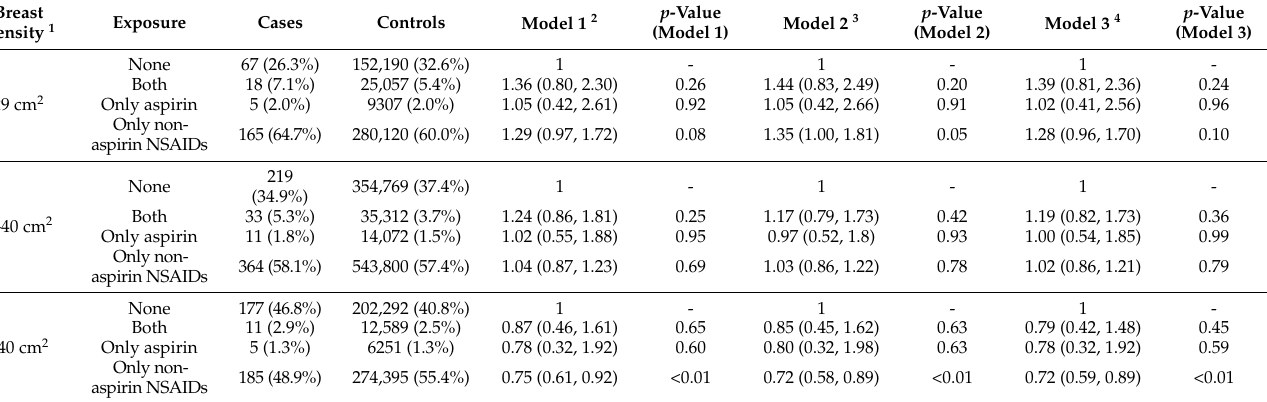
Table 4. Hazard ratios (95% confidence intervals) of breast cancer in relation to the exclusive use of NSAIDs; stratified analysis by mammographic density in an analysis of Karma participants,